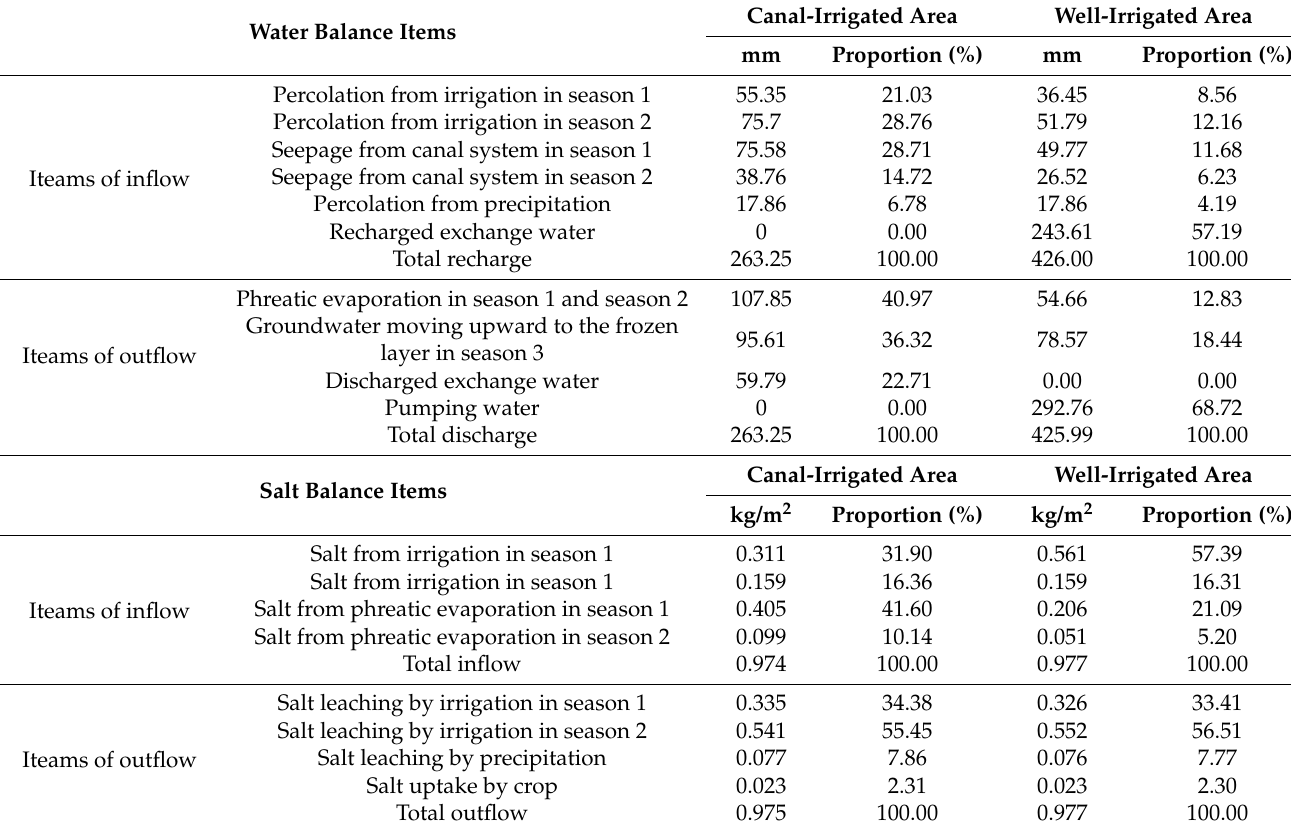
Table 7. Annual average mass balance under current